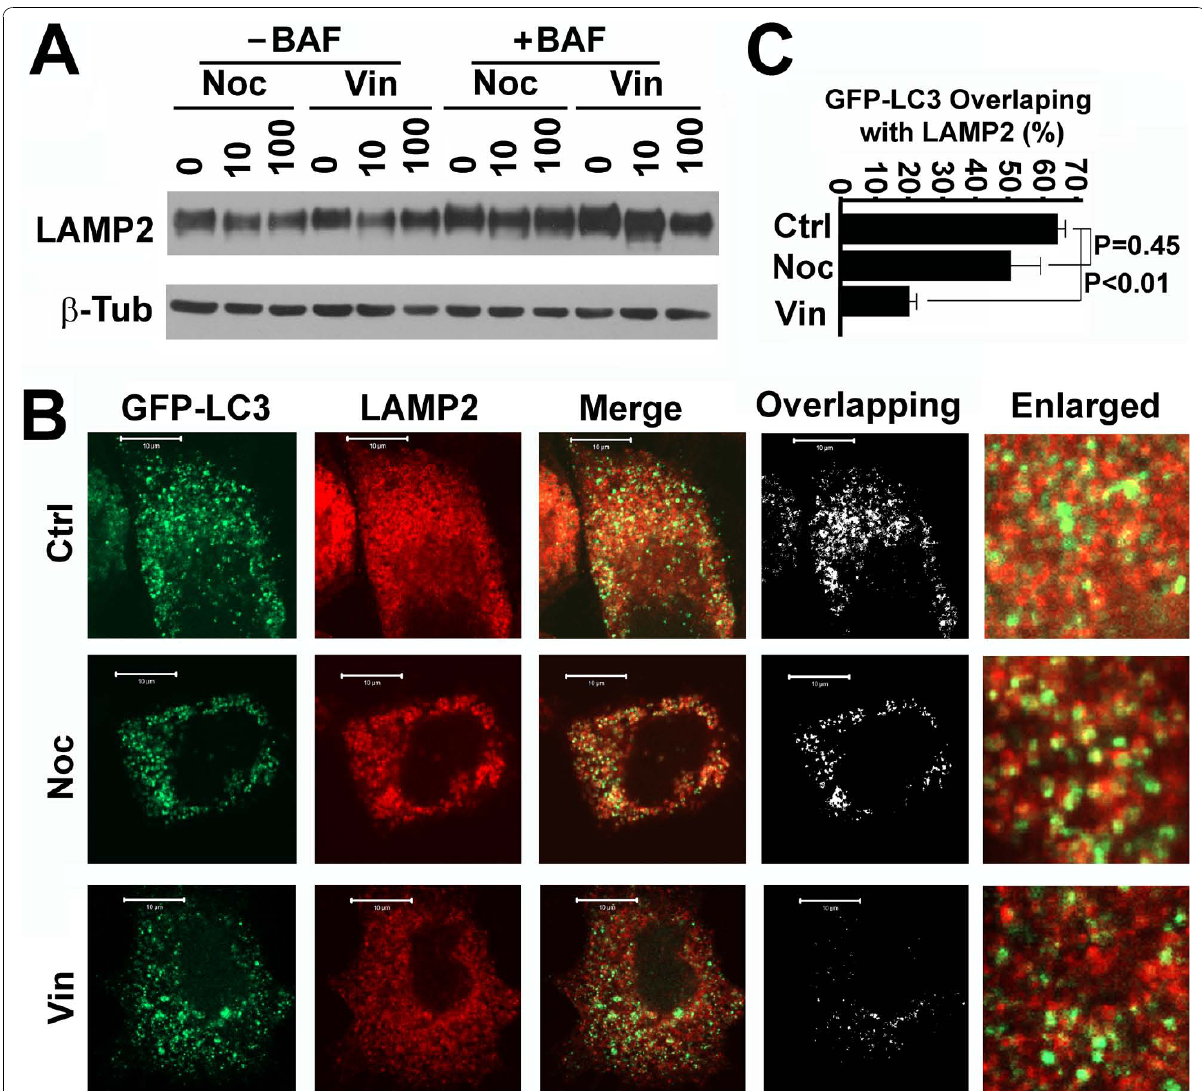
Figure 6 Vinblastine blocks autophagosome-lysosome fusion on acetylated microtubules . ( A ) Immunoblotting analysis of LAMP2 levels in HeLa cells treated with different concentrations of nocodazole and vinblastine in the absence or presence of bafilomycin A1 overnight. ( B ) Colocalization analysis of GFP-LC3 punctate foci with lysosomal marker LAMP2 in HeLa cells stably expressing GFP-LC3 treated with nocodazole or vinblastine in the presence of bafilomycin A1 overnight. LAMP2 was visualized with anti-LAMP2 primary antibody and Rhodamine-conjugated secondary antibody. The overlapping analysis was performed with the ImageJ ColocalizeRGB Plugins. ( C ) The fraction of GFP-LC3 overlapping with LAMP2 staining as calculated from images shown in (B) with the ImageJ JACoP Plugins. The data shown is the average and standard deviation of ten randomly selected images in a field of 512 pixels × 512 pixels (23.5 μ m × 23.5 μ m). The significance of differences was determined by Student ’ s